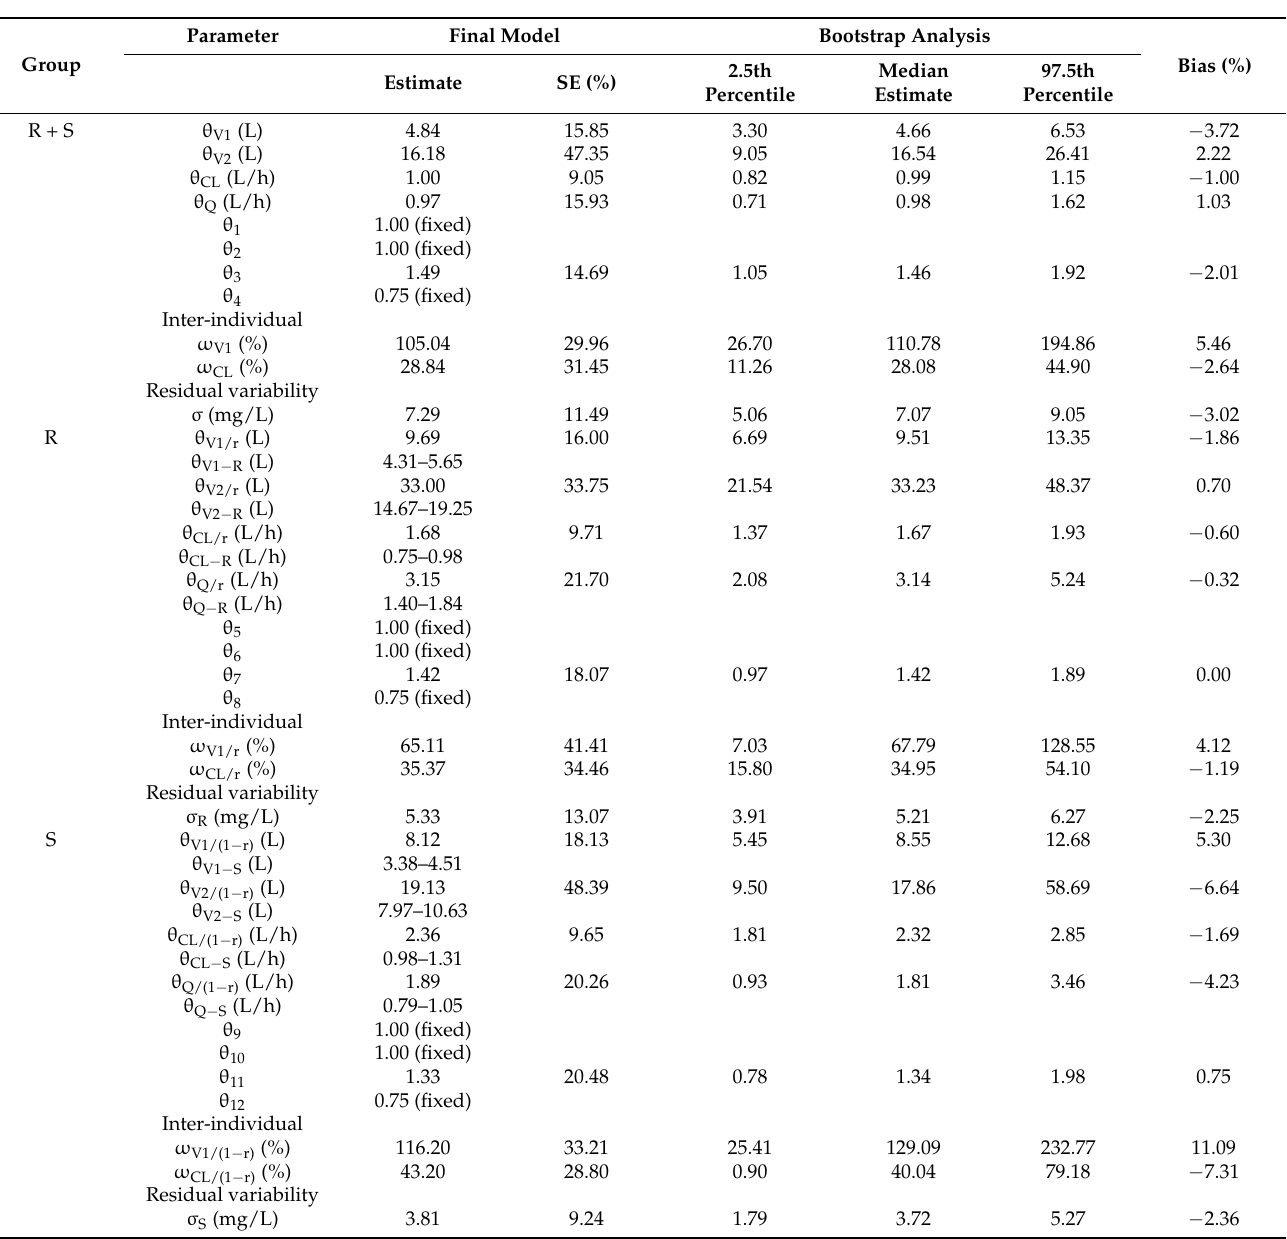
Table 3. Latamoxef and its R- and S-epimers PPK parameter estimates of the final model and bootstrap